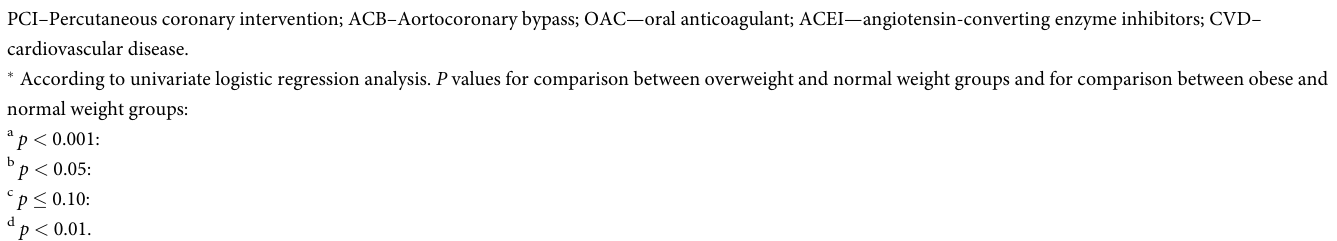
complications after 7 (0.4%), urological after 5 (0.3%), cardiac after 11 (0.7%) and cranial nerve lesions after 14 (0.9%) of all CEAs. Reoperation was necessary in 53 (3,3%) cases. Periop- erative (30-day) outcomes did not significantly differ between compared groups. The only exception were bleedings, significantly less frequent ( p < 0.05) in overweight, compared to normal weight patients. Bleedings were diagnosed based on increased drainage and the occur- rence of hematoma. There were no surgical site infections after any of the observed CEAs. Results of multivariate regression analysis are presented in Table 4. Compared to normal weight patients in whom CEAs were performed, overweight patients were significantly more frequently males ( p < 0.001), with non-insulin-dependent diabetes mellitus ( p = 0.010), and more frequent use of ACEI in hospital discharge therapy ( p = 0.012). Moreover, CEAs in them